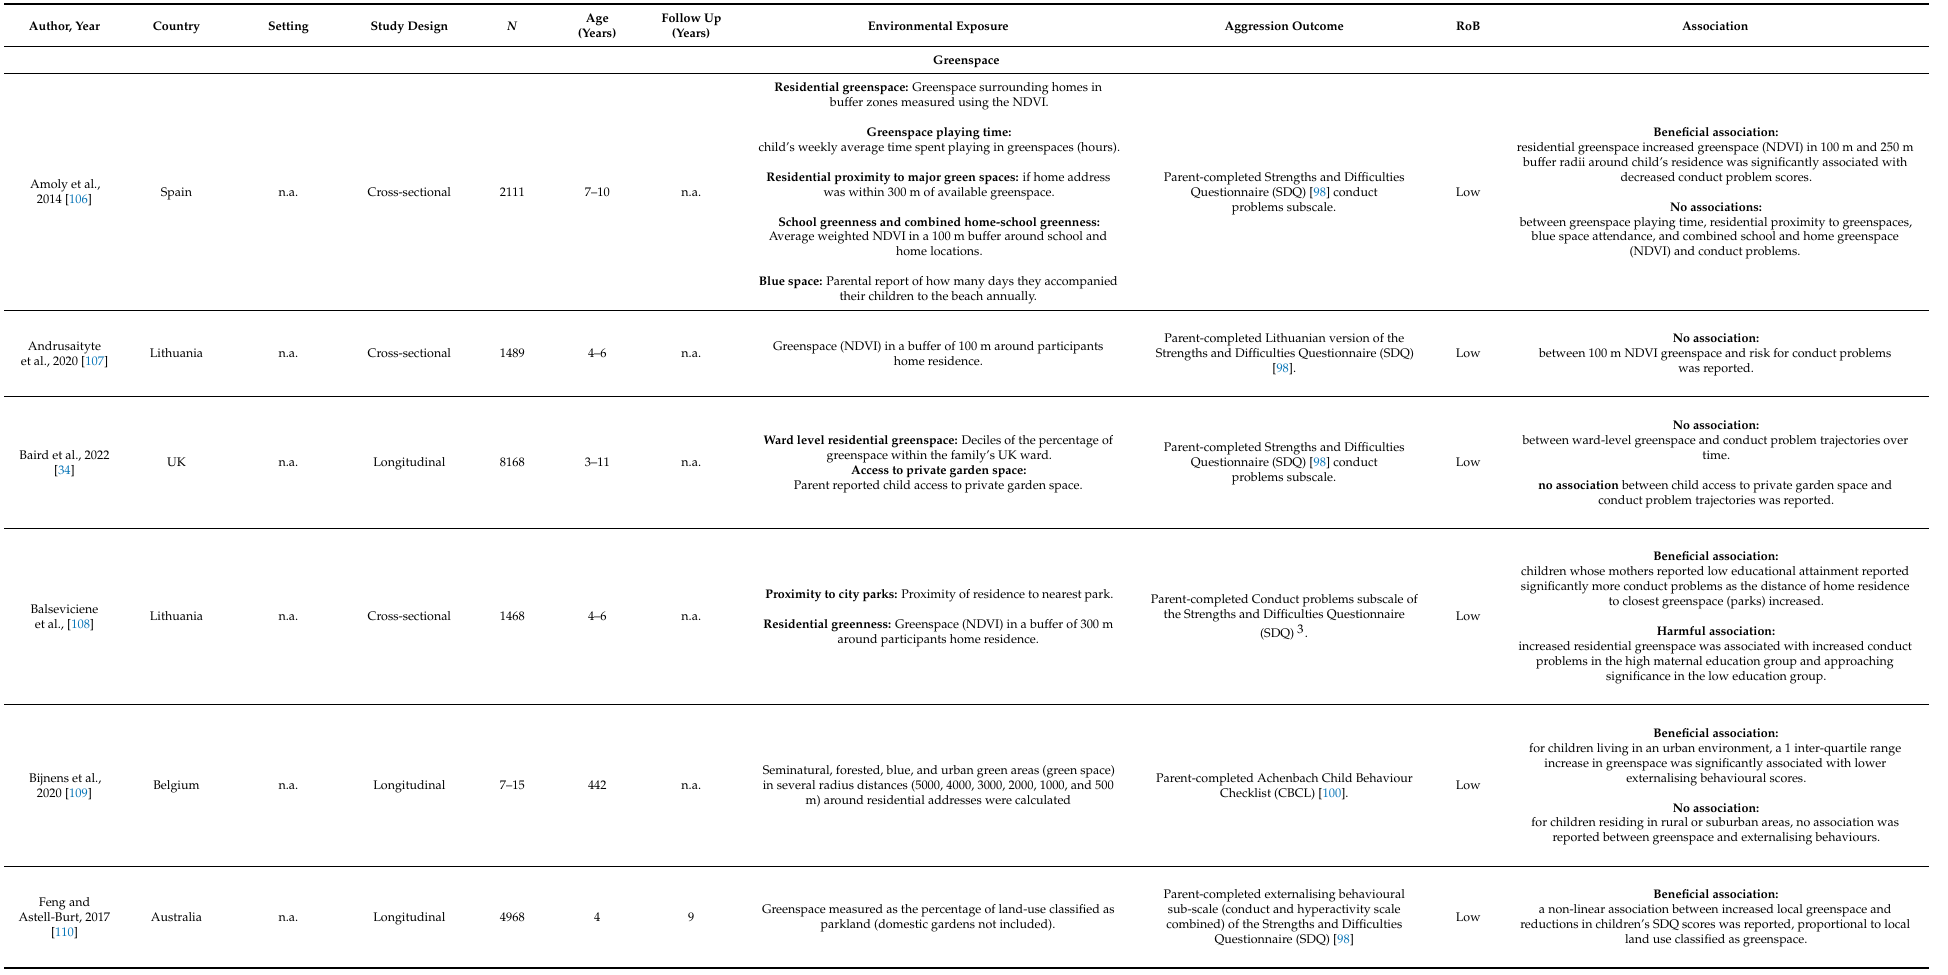
Table 1. Risk of Bias (RoB) summary for studies reporting on the association between environmental domains and aggressive behaviours in typically developing